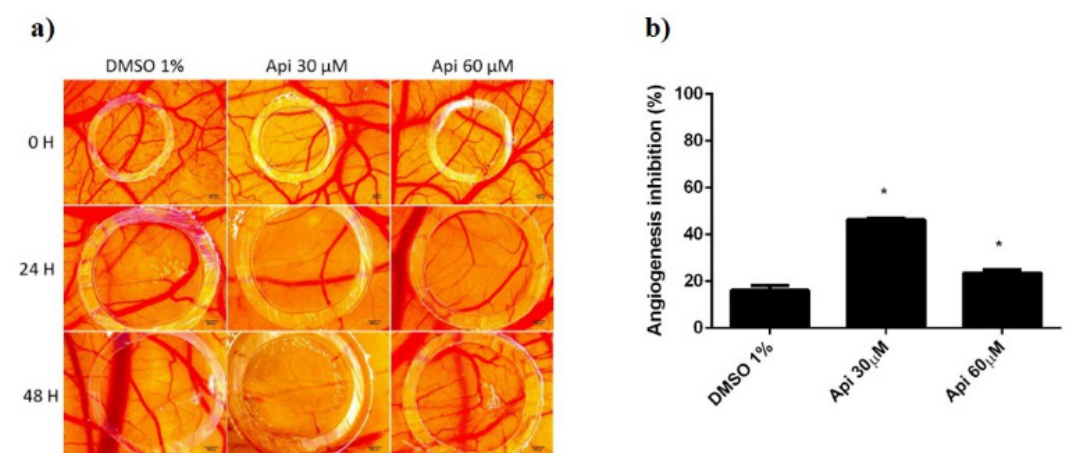
Figure 11. Normal CAMs treated with Api: ( a ) Stereomicroscopic in vivo images of the areas treated with Api 30 and 60 μ M and with DMSO 1% as solvent control: initially—0 h, after 24 h, and after 48 h; ( b ) the angiogenic inhibition % at 48 h for Api 30 μ M and 60 μ M compared to DMSO 1%. * p < 0.05.